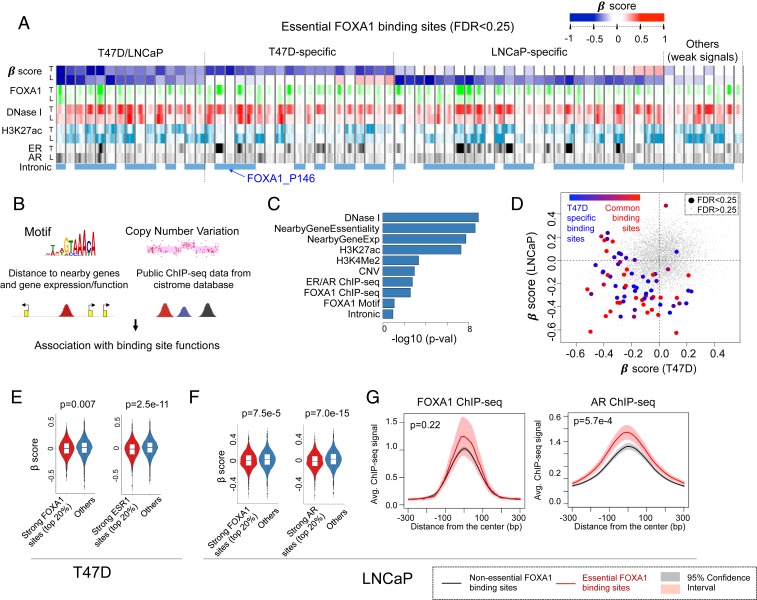
Features of FOXA1 binding sites in T47D and LNCaP cells. (A) The chromatin features of selected binding sites with statistical significance coming out of the cistrome screens. (B) Possible features that are tested for the association with binding site functions in the screens. (C) The rankings of all features associated with the functions of FOXA1 binding sites. For each feature, we compare its signal distribution between the top 5% of essential sites vs. other sites. The average of P values (calculated using the Mann–Whitney U test) across 2 cell lines is used to measure the relevance of each feature. (D) The β-scores of all sites in T47D and LNCaP cells. Sites are colored by their appearances in both cell lines: Sites that only appear in T47D or appear in both cells are colored blue and red, respectively. (E and F) The β-score distribution of the strongest FOXA1 or ESR1 sites vs. others in T47D and LNCaP cells. (G) The binding signals of the top essential FOXA1 binding sites vs. nonessential sites in LNCaP cells.